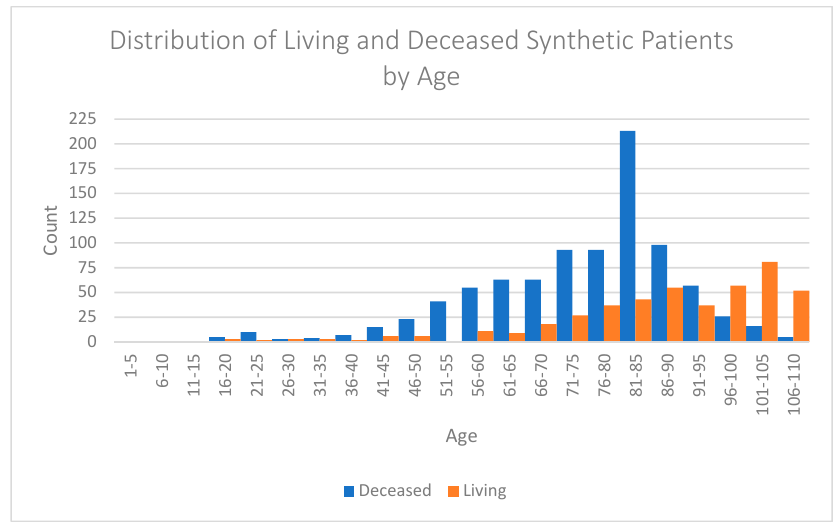
Figure A4. Distribution of deceased and living patients by age group.